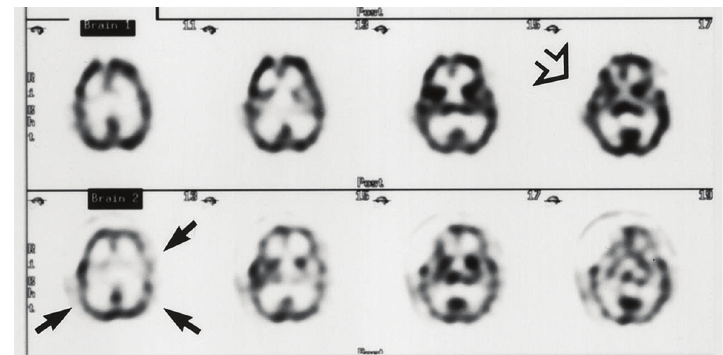
F 7: SPECT. Initial transaxial SPECT images (row 1) showing only a postoperative defect from clipping of an ACA aneurysm, demonstrated by the open arrow. Follow-up transaxial SPECT images (row 2) show diffuse hypoperfusion, indicating moderate vasospasm, demonstrated by the closed arrows. �e �gure is borrowed from [56].